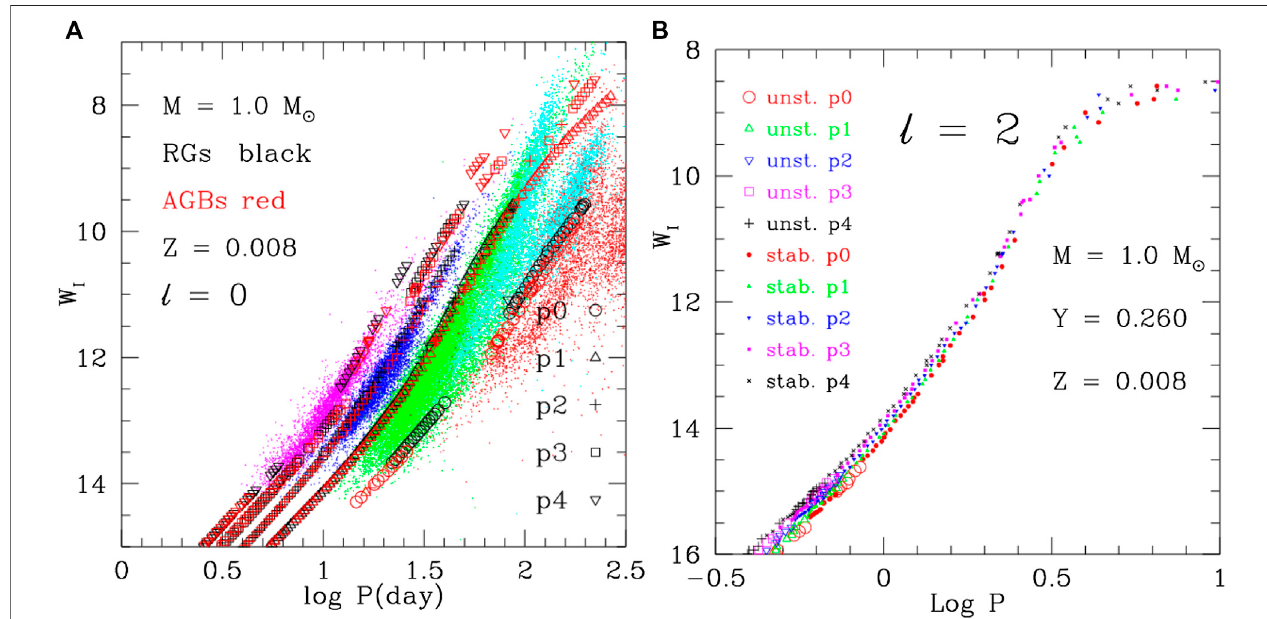
FIGURE8| Period-luminositydiagramoflow-orderradial(panela)andnon-radial(panelb)modesforevolutionarymodelsofRGs(black)andAGBs(red)withmass M (cid:2) 1 . 0 M ⊙ . The open and fi lled circles, triangles, pluses, squares, and inverse triangles are, respectively, the unstable and stable fundamental through fourth overtone modes. The observed P-L sequences A, A ′ , B, C ′ , and C are shown by magenta, blue, green, cyan, and red small